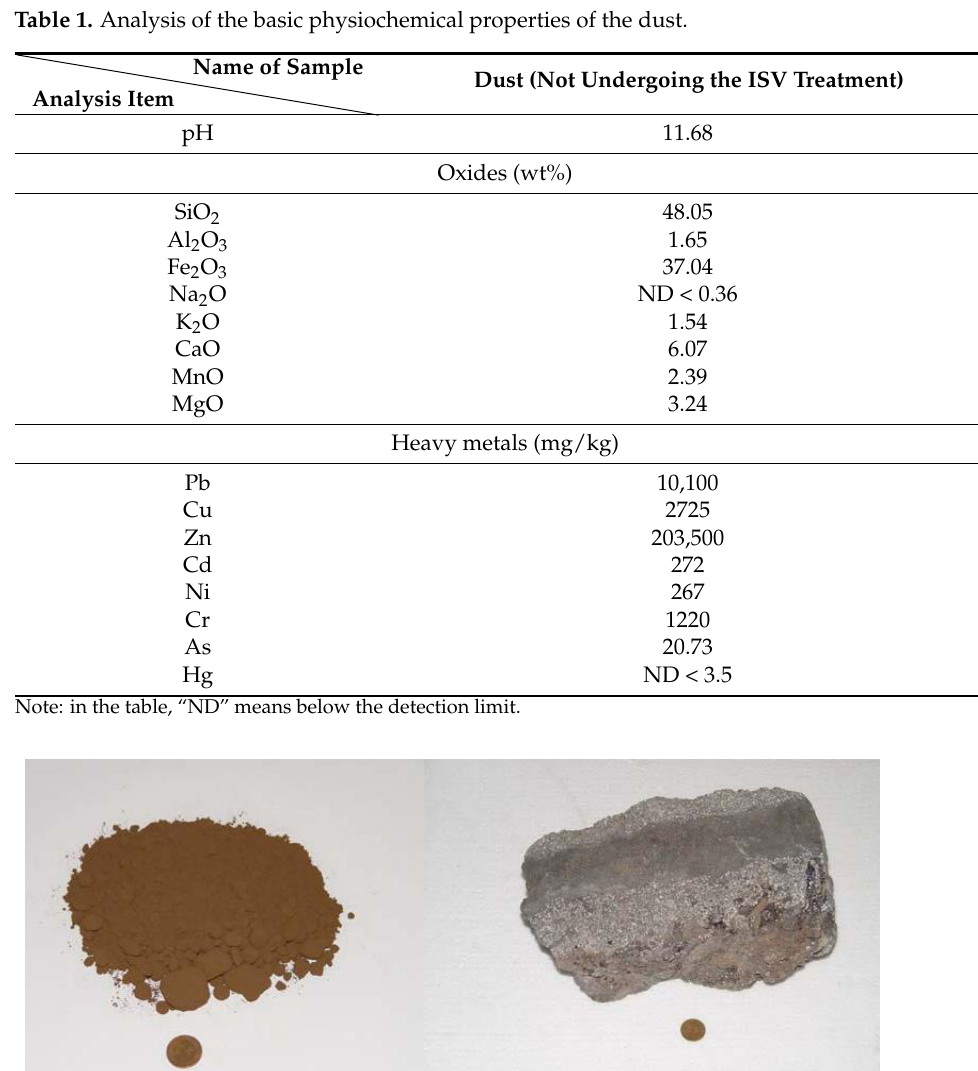
Table 1. Analysis of the basic physiochemical properties of the dust.